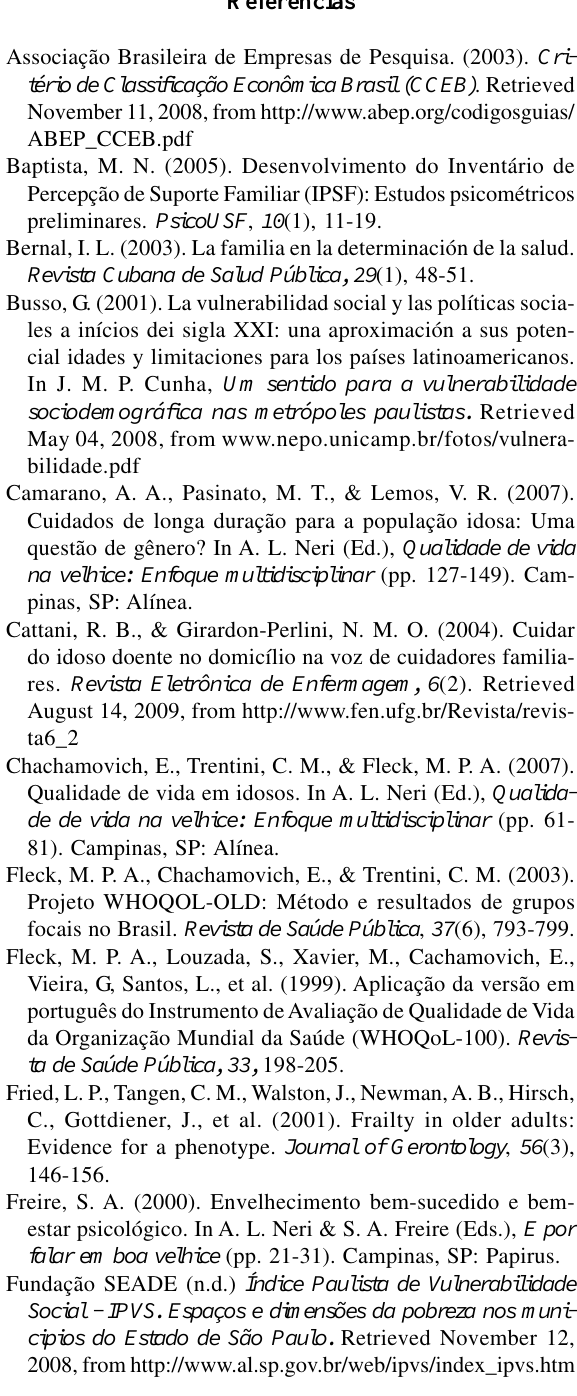
Associação Brasileira de Empresas de Pesquisa. (2003). Cri- tério de Classificação Econômica Brasil (CCEB) . Retrieved November 11, 2008, from http://www.abep.org/codigosguias/